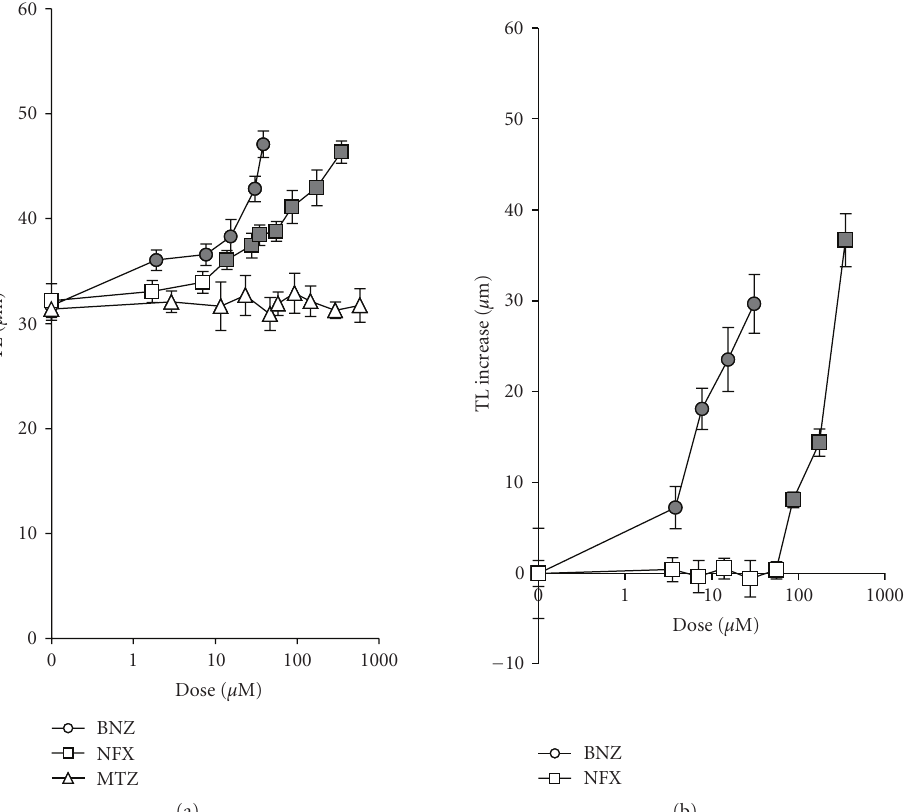
Figure 2: DNA damage detected in human leukocytes treated (37 ◦ C, 1 hour) with NFX, BNZ, and MTZ. (a): DNA damage is expressed as total migration length (TL, μ m) detected by the alkaline comet assay. (b) Specific oxidatively generated damage to DNA detected by the modified comet assay (ENDO III). DNA oxidative damage is expressed as DNA migration ( μ m) increase with respect to the assay without enzymes. Mean ± SD of three independent experiments. Filled symbols, P < . 05 (Dunnett’s C) with respect to dose 0.